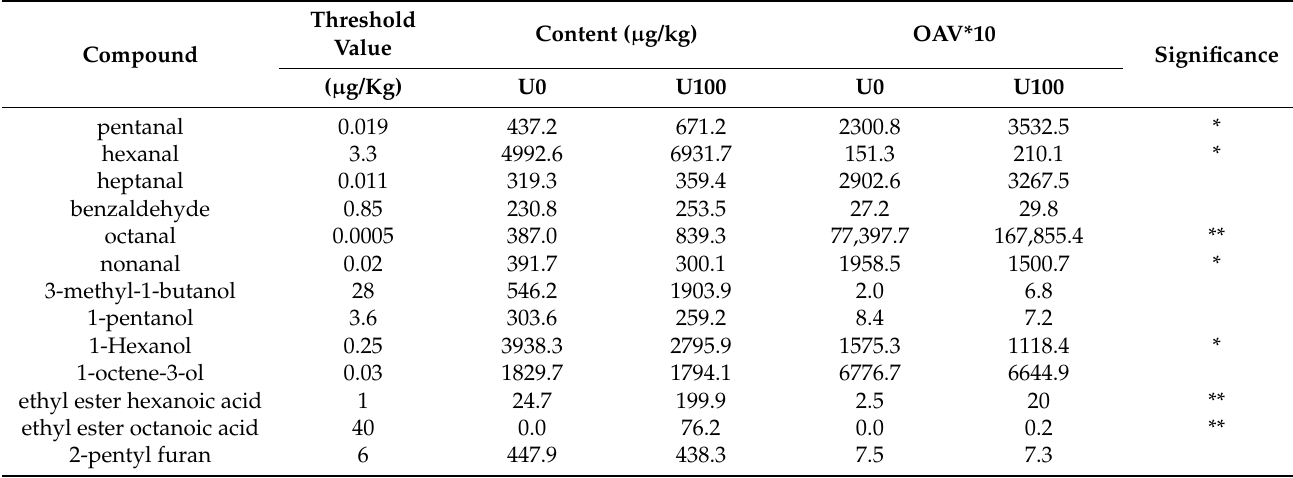
Table 1. Concentration and OAV values of odor-active compounds in Suanzhayu (fermentation 14 day) with (U100) and without (U0)